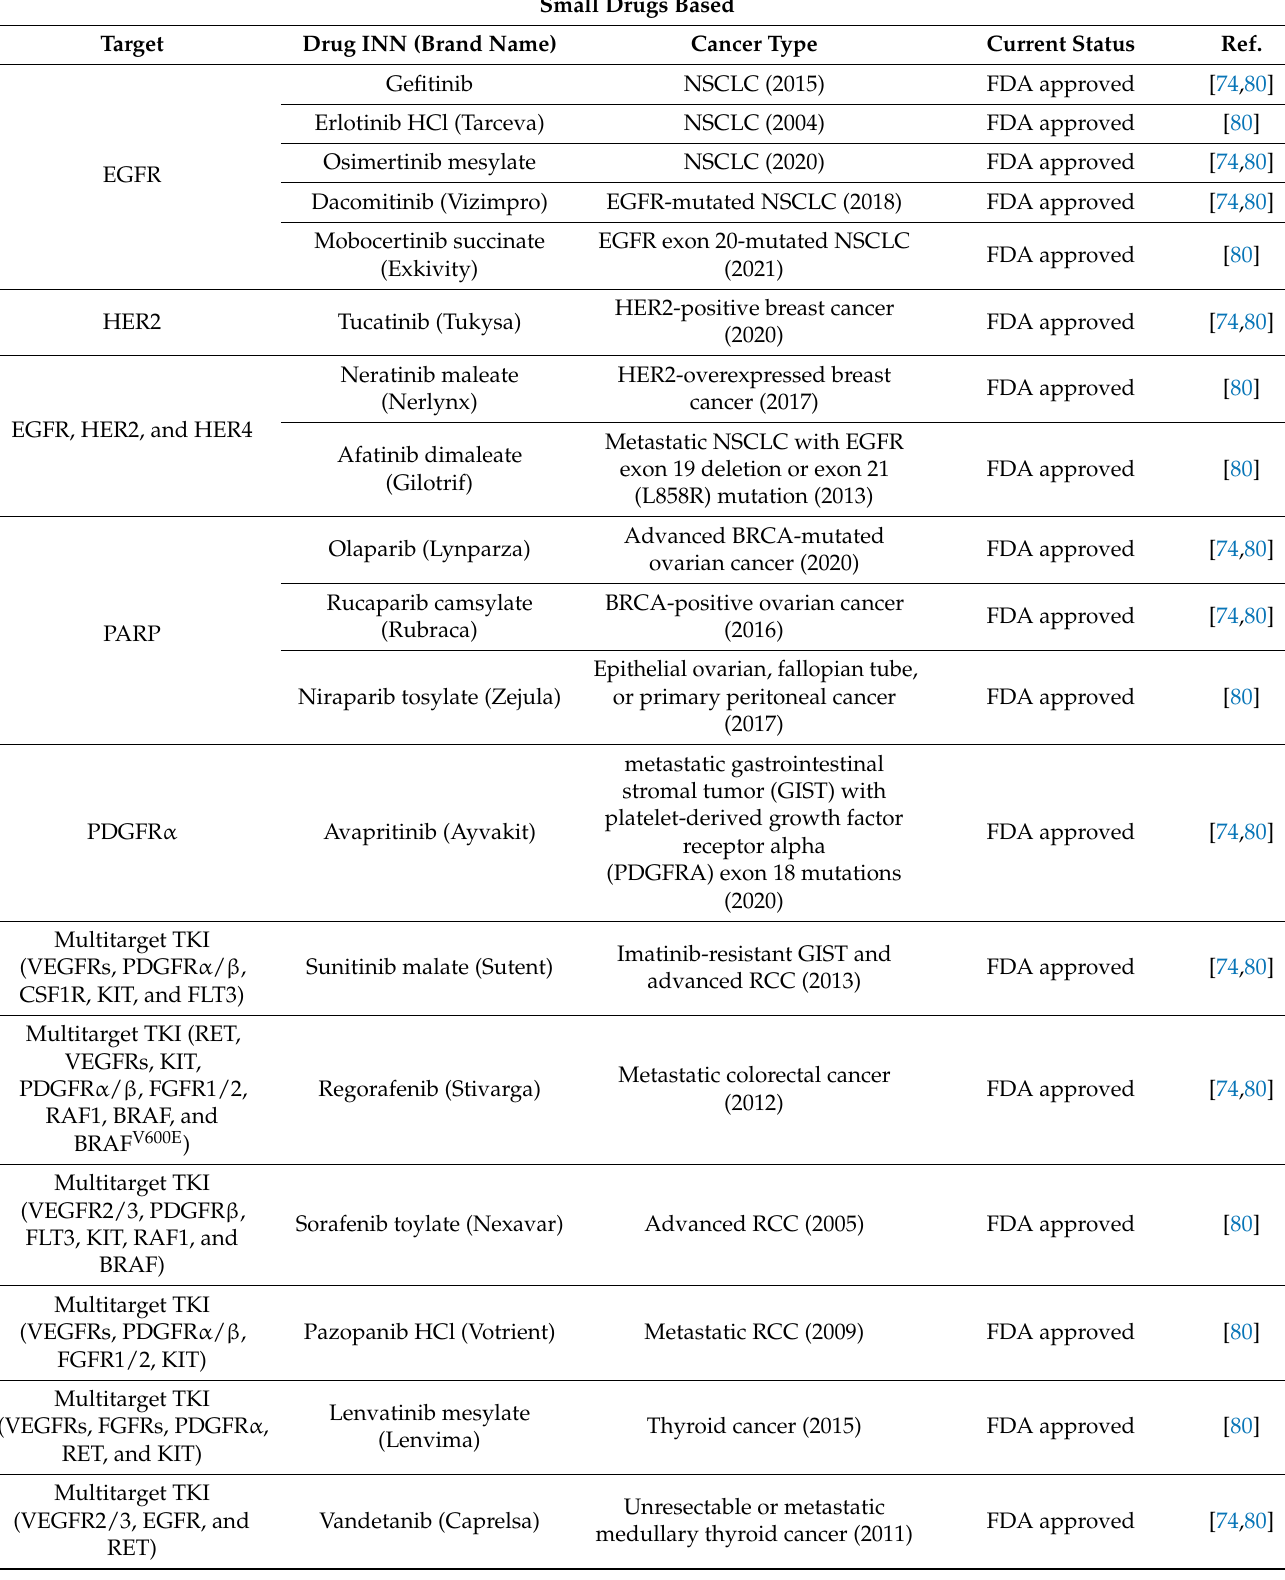
Table 2. Summary of small drugs